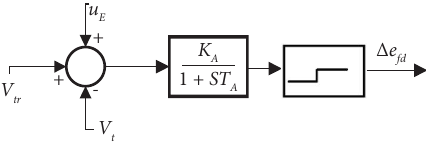
Figure 3: Te power system model under